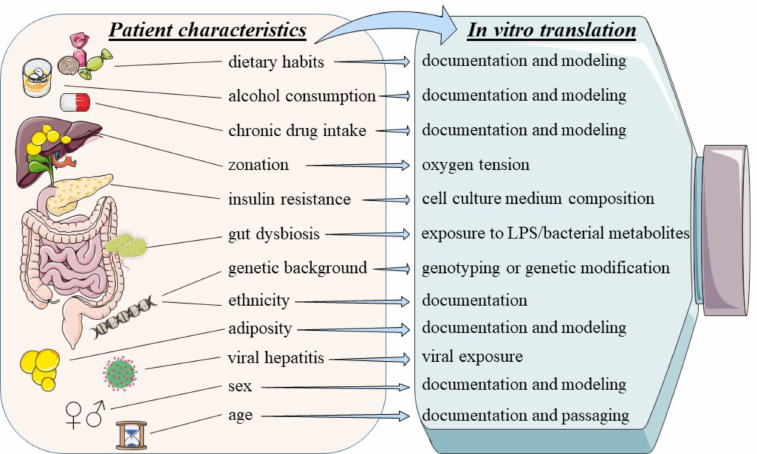
Figure 3. Translation of MAFLD patient characteristics to an in vitro environment. Multiple factors contribute to the phenotypical presentation of MAFLD. Cells used for setting up in vitro MAFLD disease models may inherently exhibit disease modifiers that require proper documentation of their origin in the first instance. Well-established culture conditions including non-physiological cell culture medium composition and oxygen tension may also influence specific pathogenic